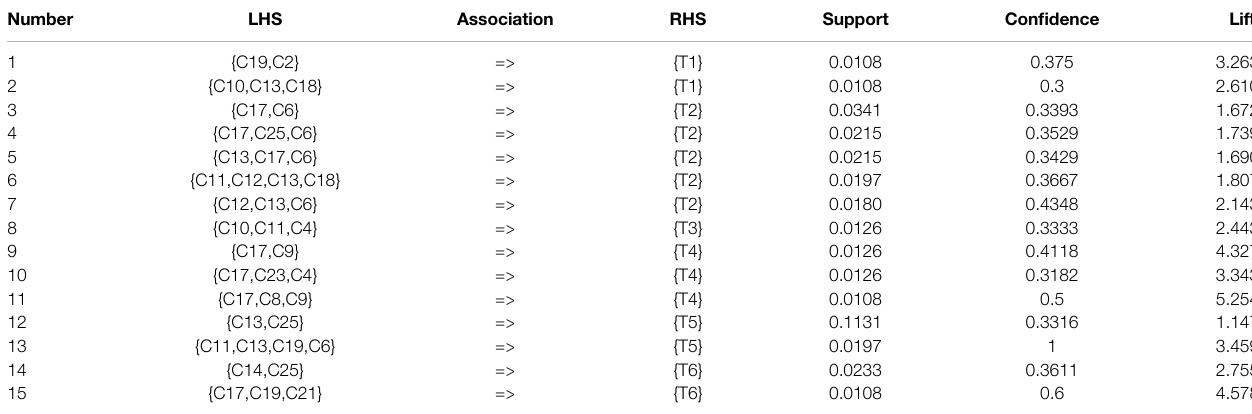
TABLE 4 | Association analysis results between the accident causal factors and the accident types (part). Number